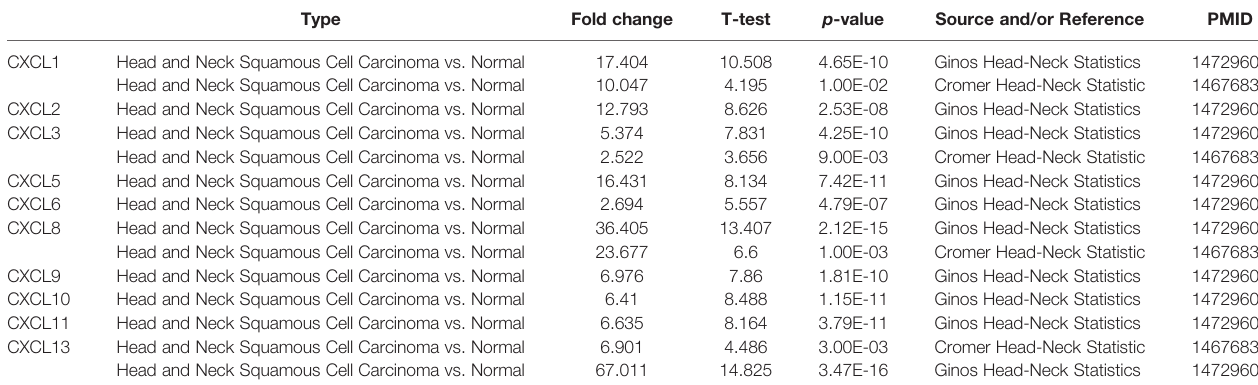
TABLE 1 | The signi fi cant changes of CXC-chemokine expression in transcription level between different types of HNSCC and normal tissues (oncomine). Type Fold change T-test p -value Source and/or Reference PMID